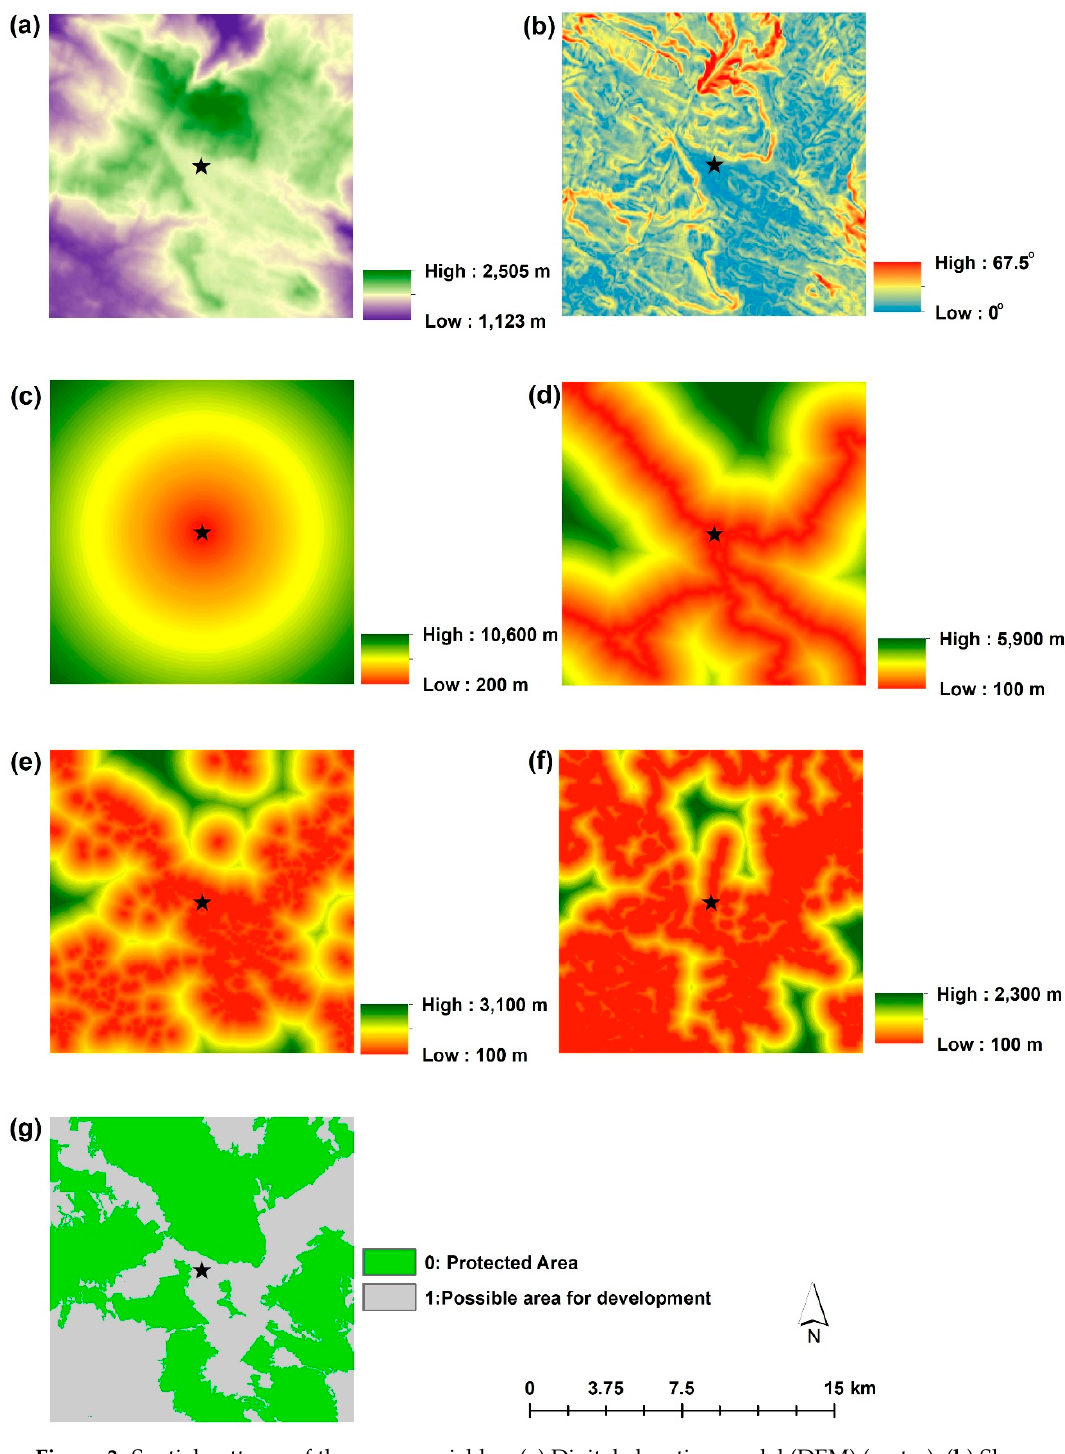
Figure 3. Spatial patterns of the seven variables: ( a ) Digital elevation model (DEM) (meter); ( b ) Slope (degrees); ( c ) Distance from Nuwara Eliya City center (interval of 200 m); ( d ) Distance from main road (interval of 100 m); ( e ) Distance from persistent built-up area during 2006–2017 (interval of 100 m); ( f ) Distance from footpath and jeep and cart road (interval of 100 m); and ( g ) Protected forest and water reserves.